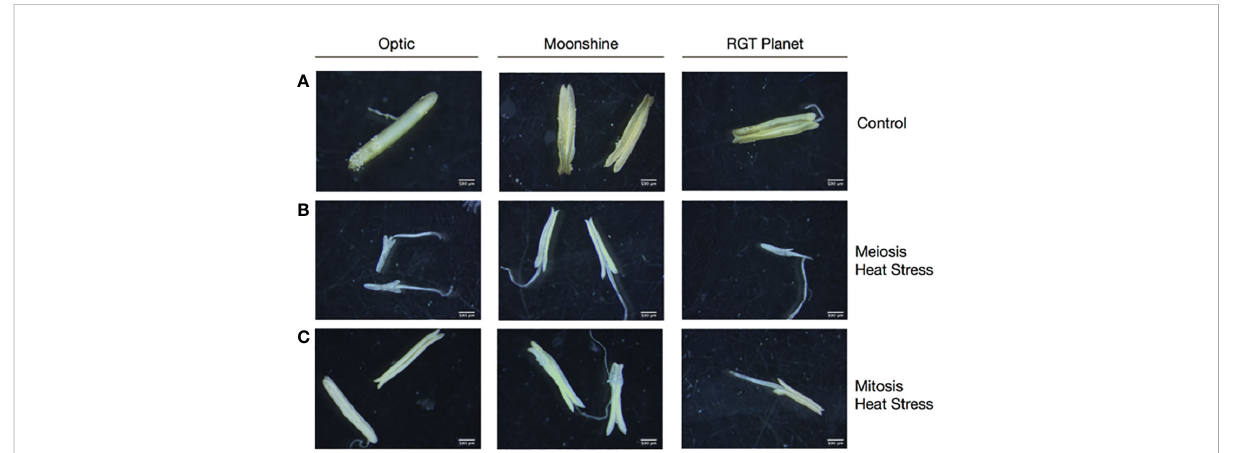
FIGURE 1 Anther development in barley cultivars Optic, Moonshine and RGT Planet. Representative anthers dissected from a minimum of three fl orets from Control (A) and heat stressed fl orets, (B) Heat Stress during Pollen Mother Cell meiosis and (C) Pollen Mitosis show differences in anther development under the different